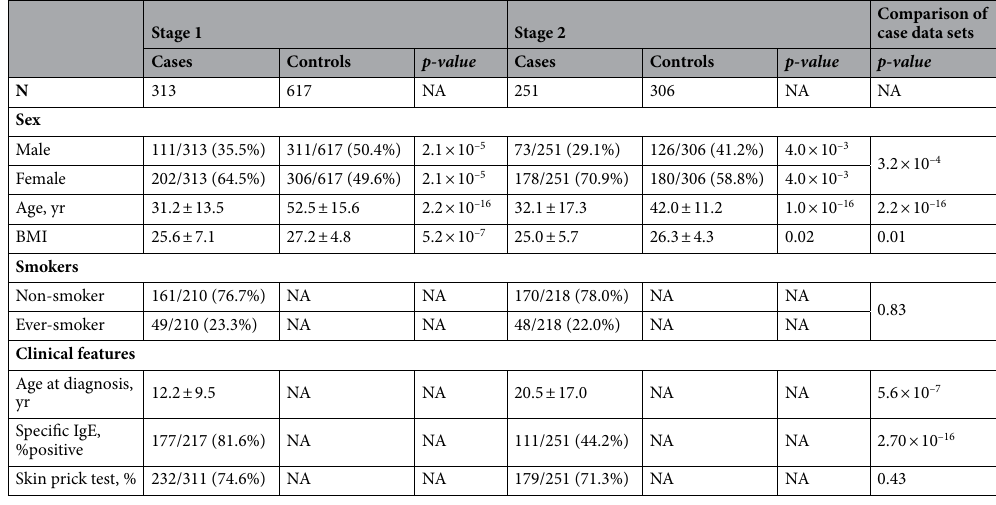
Table 1. Demographic and clinical characteristics of the individuals included in the study. Age and body mass index (BMI) values are represented by means ± SD; N = no. of participants; NA = not available. Statistical differences were obtained by Chi-squared tests for sex, smokers, specific IgE, and skin prick test; and by Wilcoxon tests for age, BMI, and age at